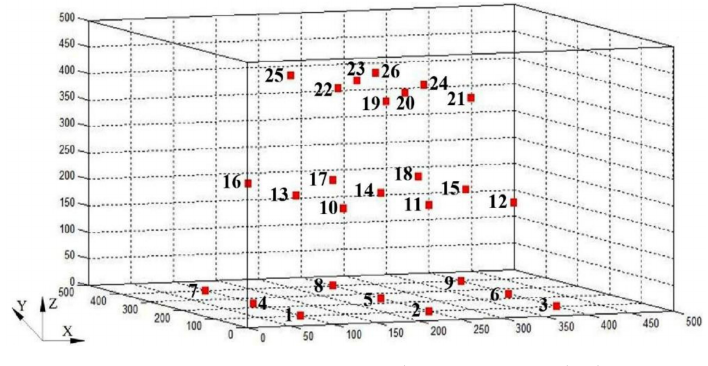
Figure 4. Sensor positions in the grouting test-bed. Table 2. Visualization system sensor coordinates in the grouting